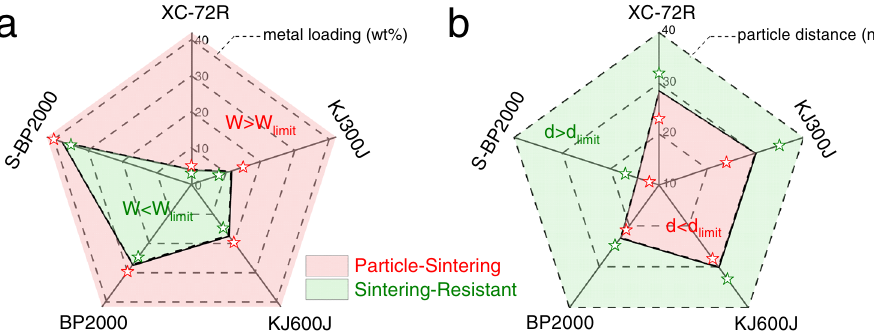
Fig. 3 Critical Pt loading and particle distance. a Critical Pt loading of the Pt/C catalysts for mitigating catalyst sintering. b Critical particle distance of the Pt/C catalysts for mitigating catalyst